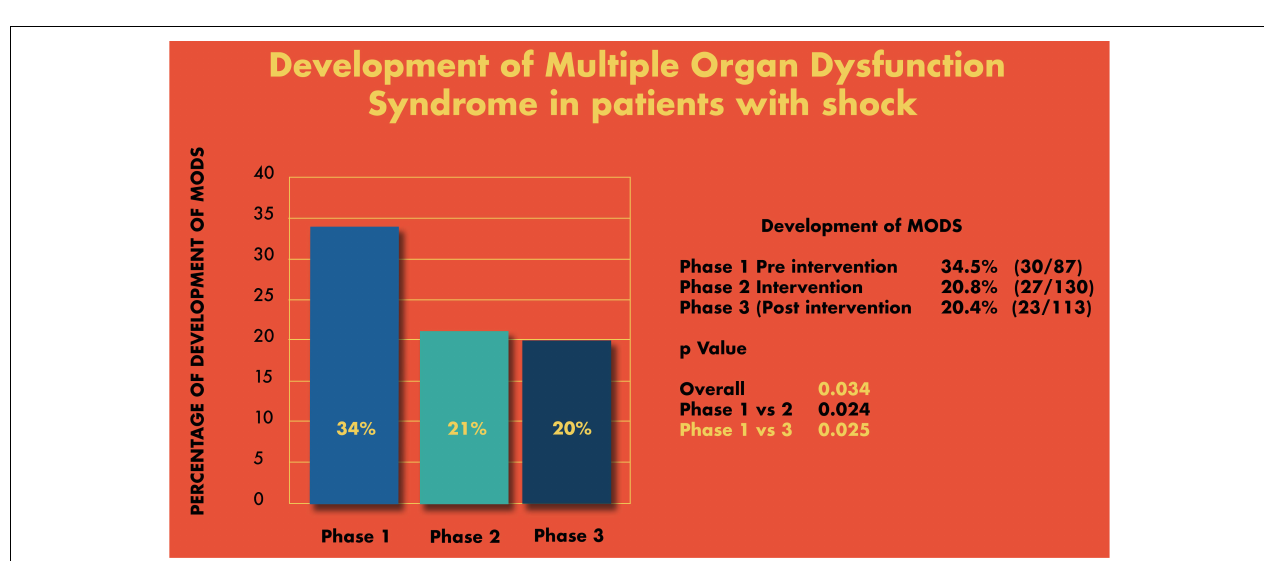
FIGURE 12 | Development of Multiple Organ Dysfunction Syndrome (MODS) in patients with